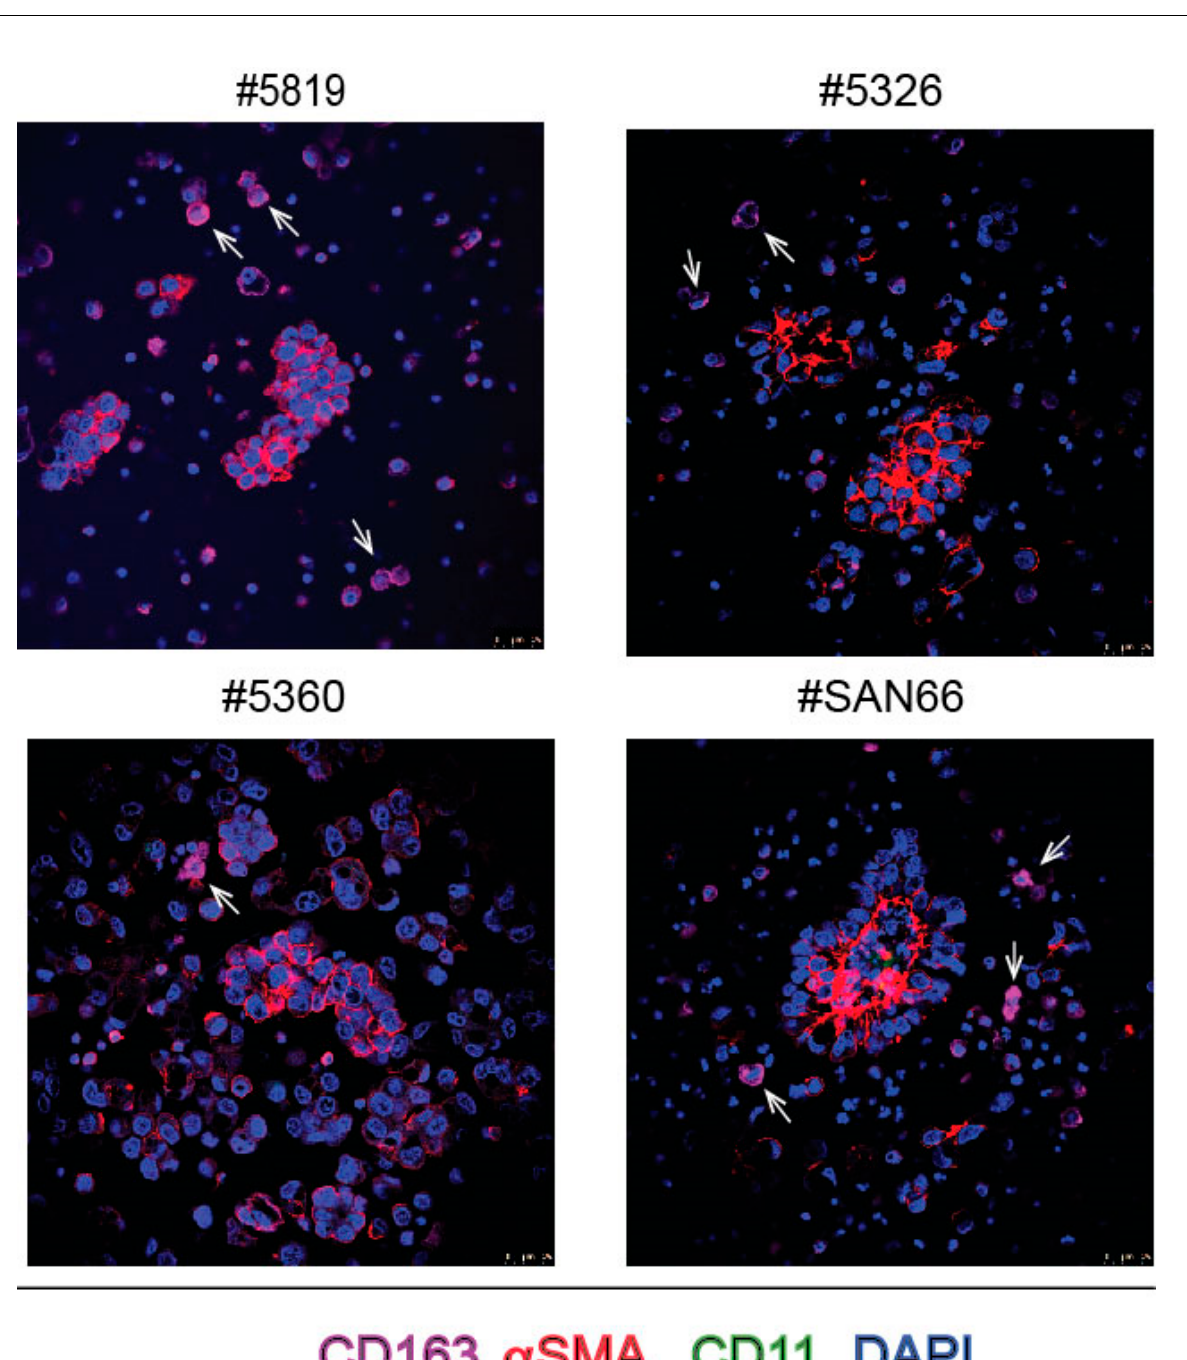
Figure 8. IF staining of spheroids from bulk ascites samples with α SMA MAb and DAPI together with CD11 and CD163 MAbs used as to visualize macrophages. The rare CD163 positive cells are indicated by arrows.